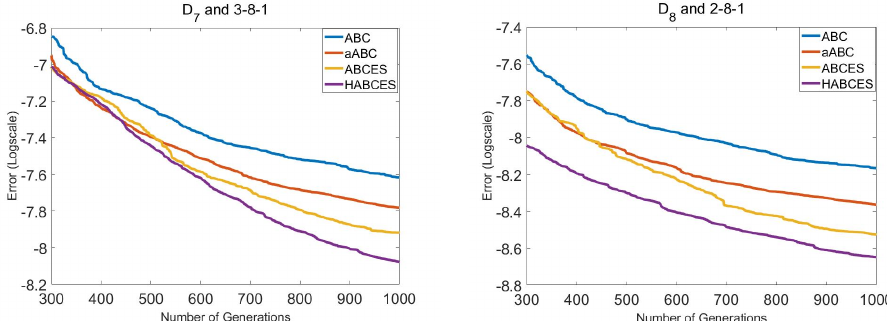
Figure 8. Comparison of the convergences of the ABC, aABC, ABCES and HABCES algorithms for nonlinear dynamic system identification.